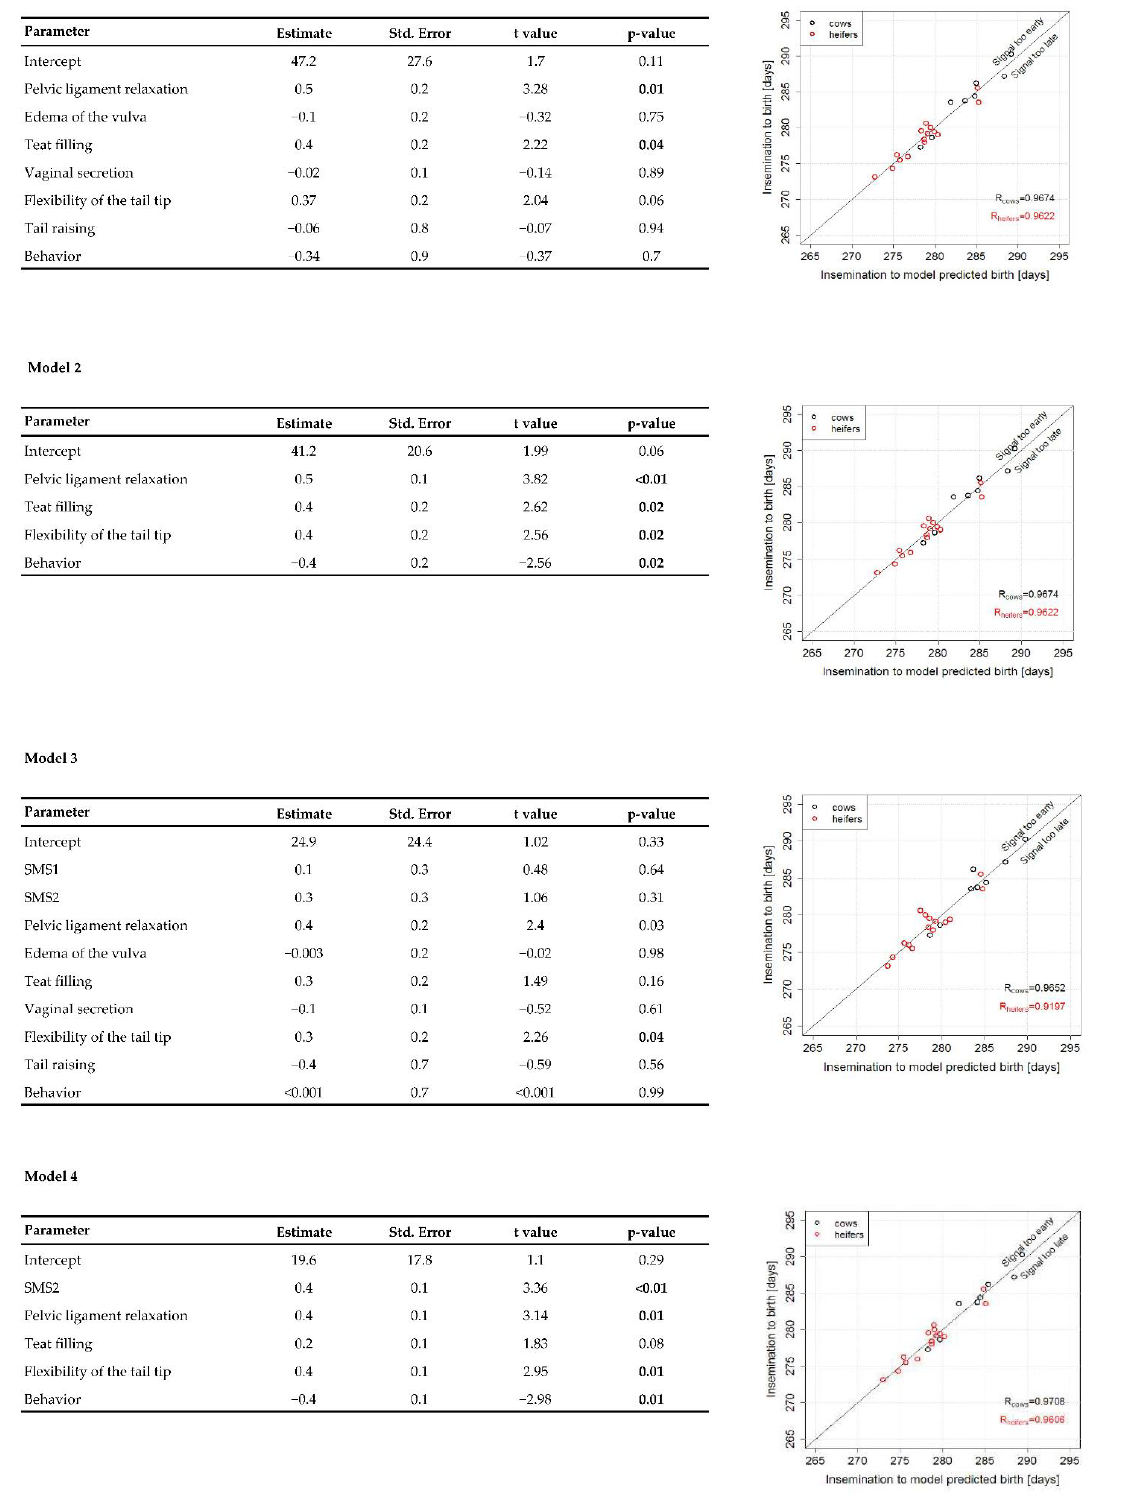
Figure 3. Statistical models without (models 1 and 2) and with (models 3 and 4) information from the remote calving sensor Moocall in form of short message services (SMS) to predict calving without (models 1 and 3) and with (models 2 and 4) automatic parameter selection. Models 1 and 3 are full models, and models 2 and 4 are models after automatic variable selection. SMS1: enhanced tail activity registered over one hour; SMS2: high tail activity continued during the consecutive